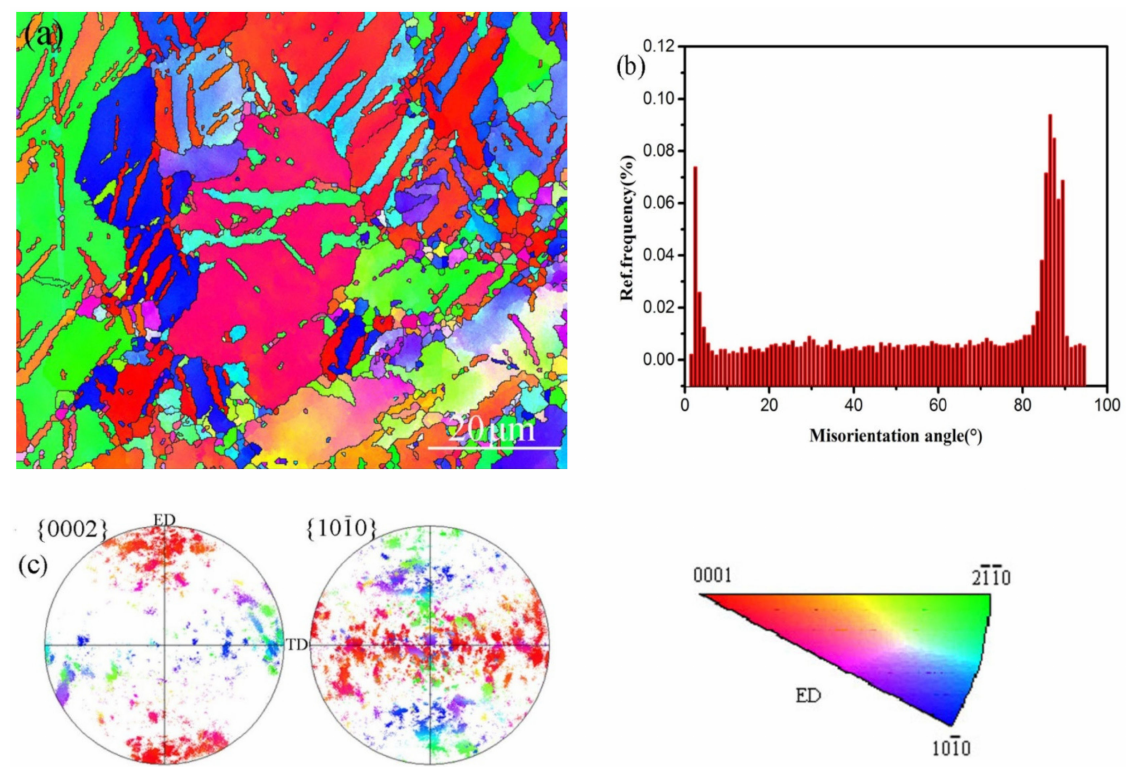
− Figure 4. EBSD results illustrating the occurrence of {10 12} twins:( a ) Inverse pole figure map of the sample subjected to 175 MPa, ( b ) Misorientation angle showing the appearance of 86.3 ± 5 ◦ and ( c ) pole figure showing basal planes parallel to ED after strain. ED stands for the extrusion direction and TD stands for the transverse direction of the extruded